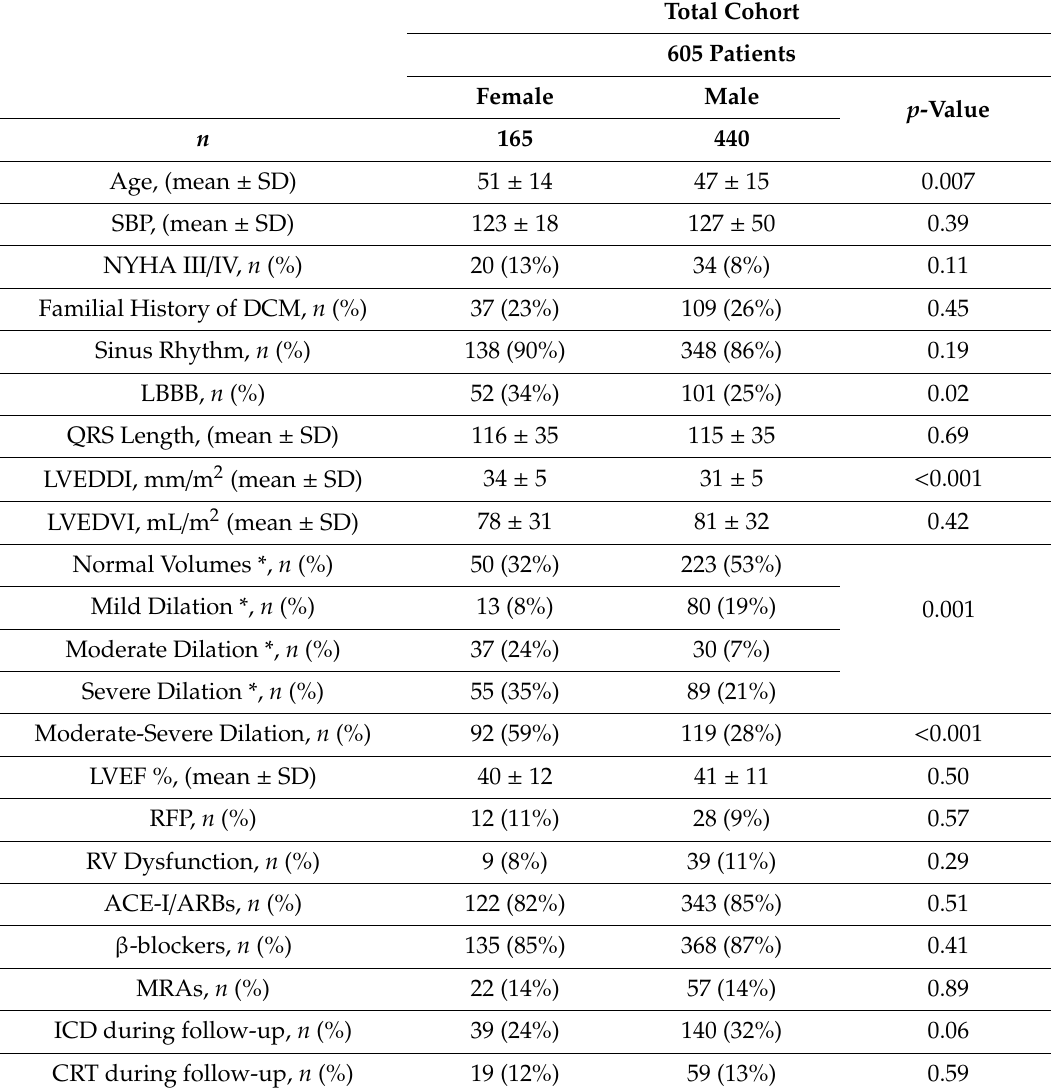
Table 1. Characteristics of the Population at 24-month